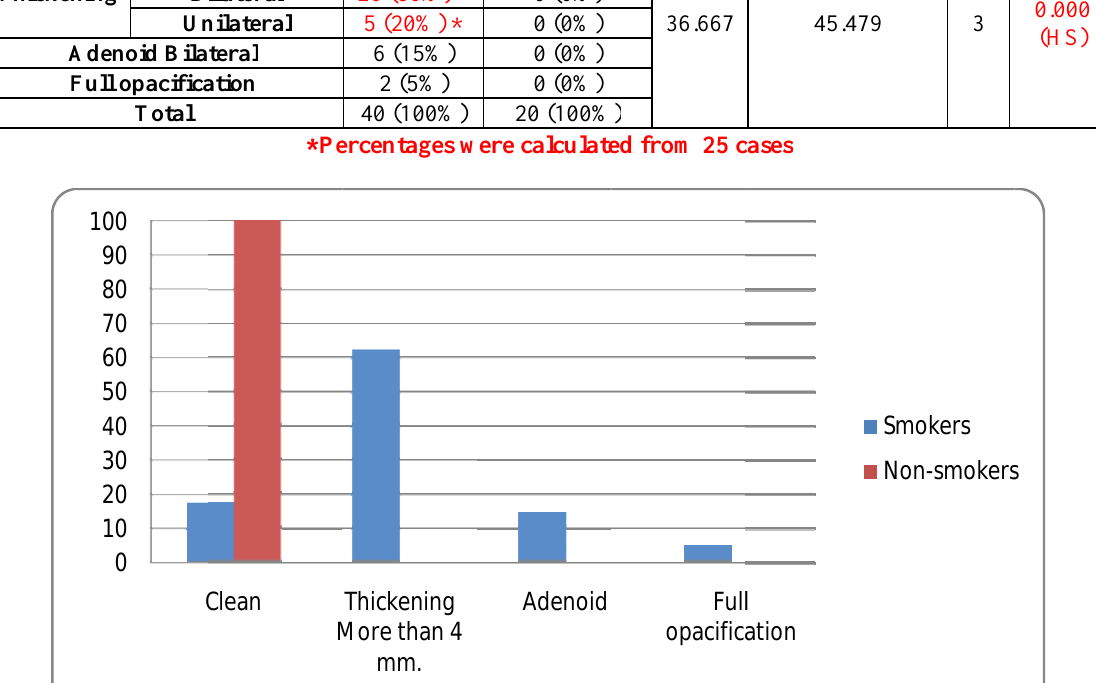
Figure 4: Figure 4: The